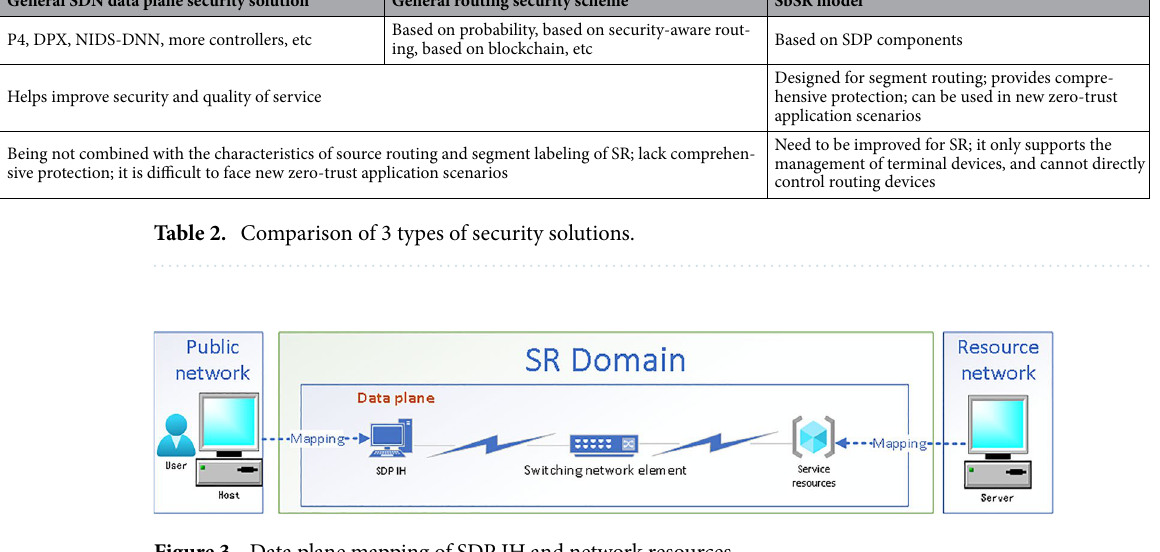
Figure 3. Data plane mapping of SDP IH and network